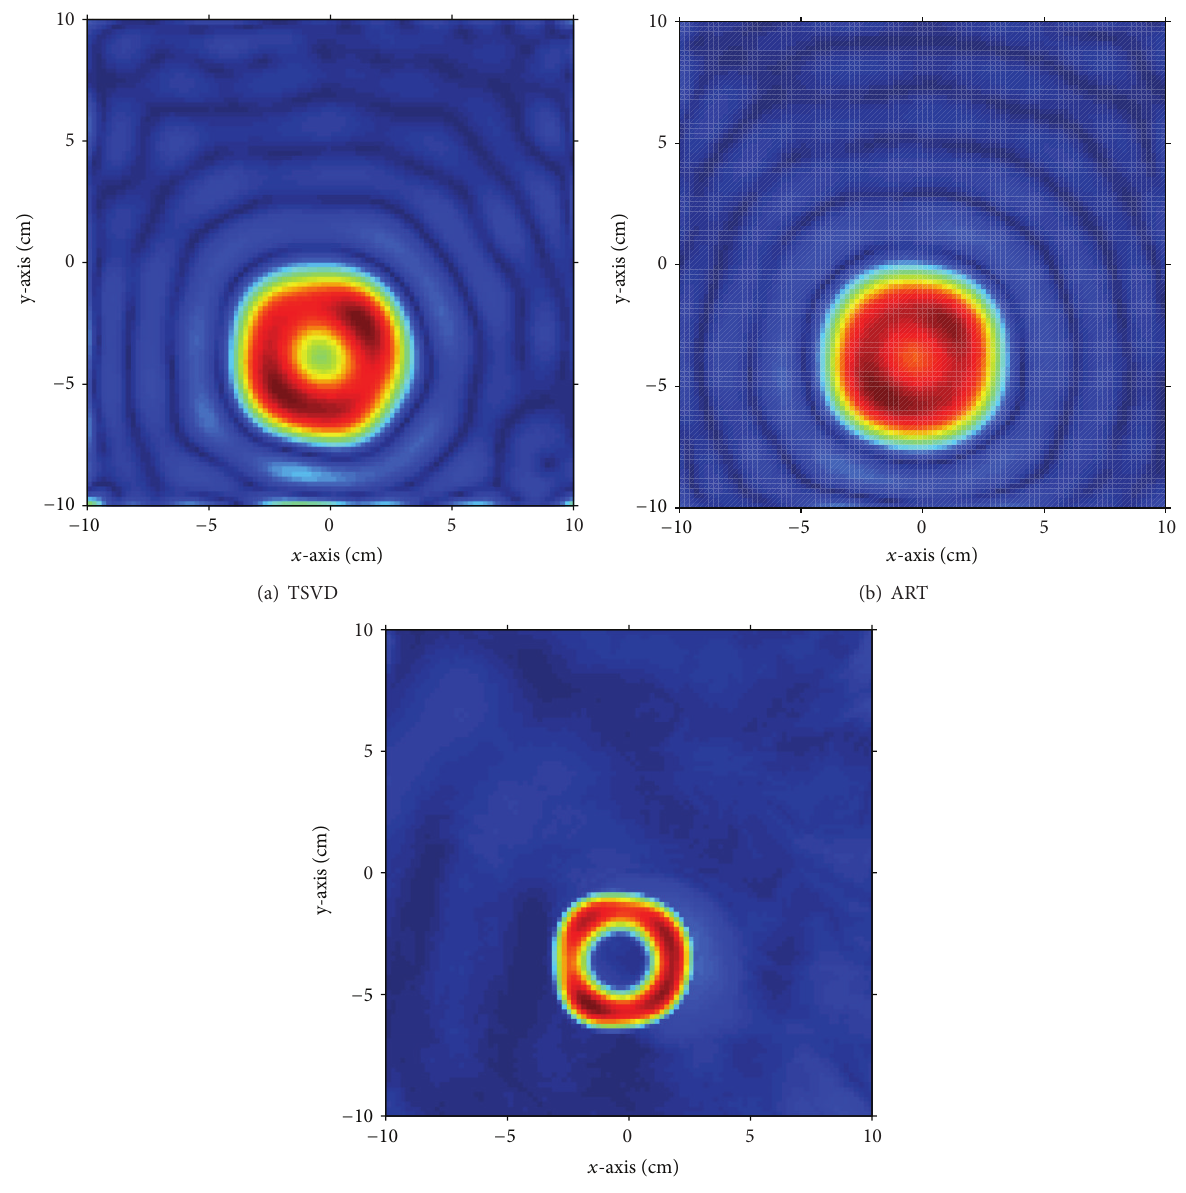
Figure 3: The figure shows reconstruction from simulated scattered electric fields, for an empty PVC pipe. TSVD (a) offers reconstruction very similar to ART (b), but the best image is obtained by using ART with the introduction of physical bounds (c). Both (b) and (c) have been obtained with 𝜇 = 1 . All images have been normalized to their maximum since quantitative reconstruction is not of